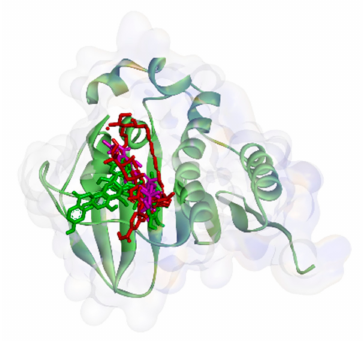
Figure 3. Ligand positions in DNA gyrase.